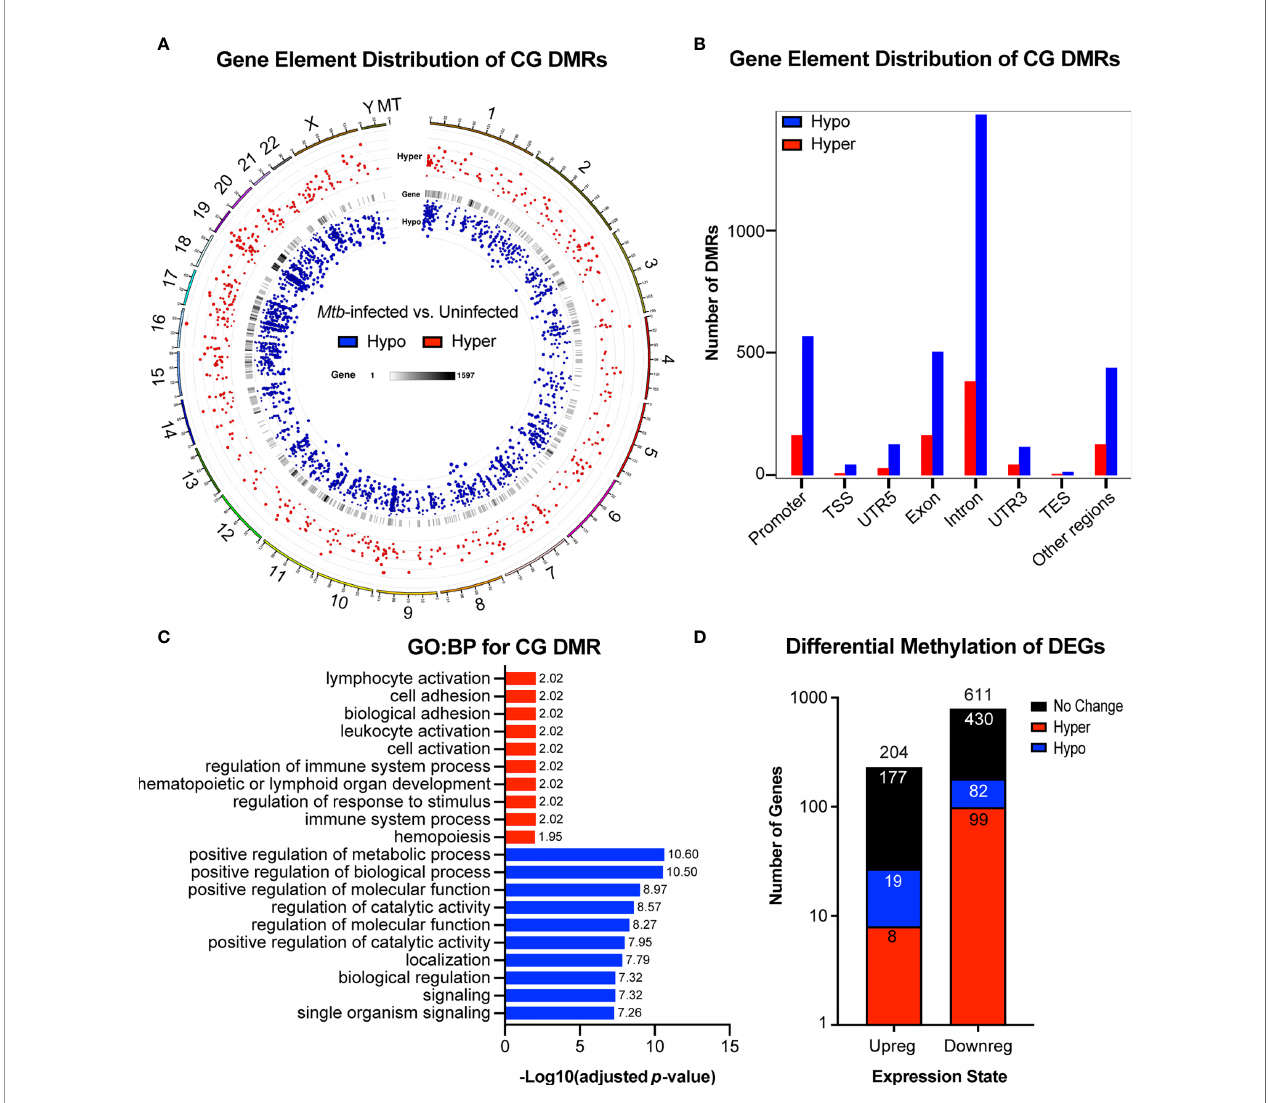
FIGURE 5 | Genome wide differential CG methylation patterns show enrichment for genes associated with immune activation and metabolic processing. (A) Genome wide chromosomal alignment of hypo (blue) and hyper (red) methylated CG sites in Mtb -infected MDMs. (B) Distribution of hypo and hypermethylated CGs (DMRs) over each genetic element. (C) Functional enrichment gene ontology biological process (GO : BP) analysis for all differentially methylated CGs. -Log 10 (adjusted p -value) values are reported to the right of each bar. GO : BP terms associated with hypermethylated CG DMRs are highlighted in red. Terms associated with hypomethylated CG DMRs are highlighted in blue. (D) Total number of up and downregulated genes from RNA sequencing results ( Figure 6 ) with overlay of genes that are also hypo or hypermethylated. Number in each color coded segment represents total number of genes with a speci fi c expression and methylation state. Number above each bar represents total up or downregulated genes. n =4. MDMs were infected with Mtb H37Rv for 48 hours at MOI=